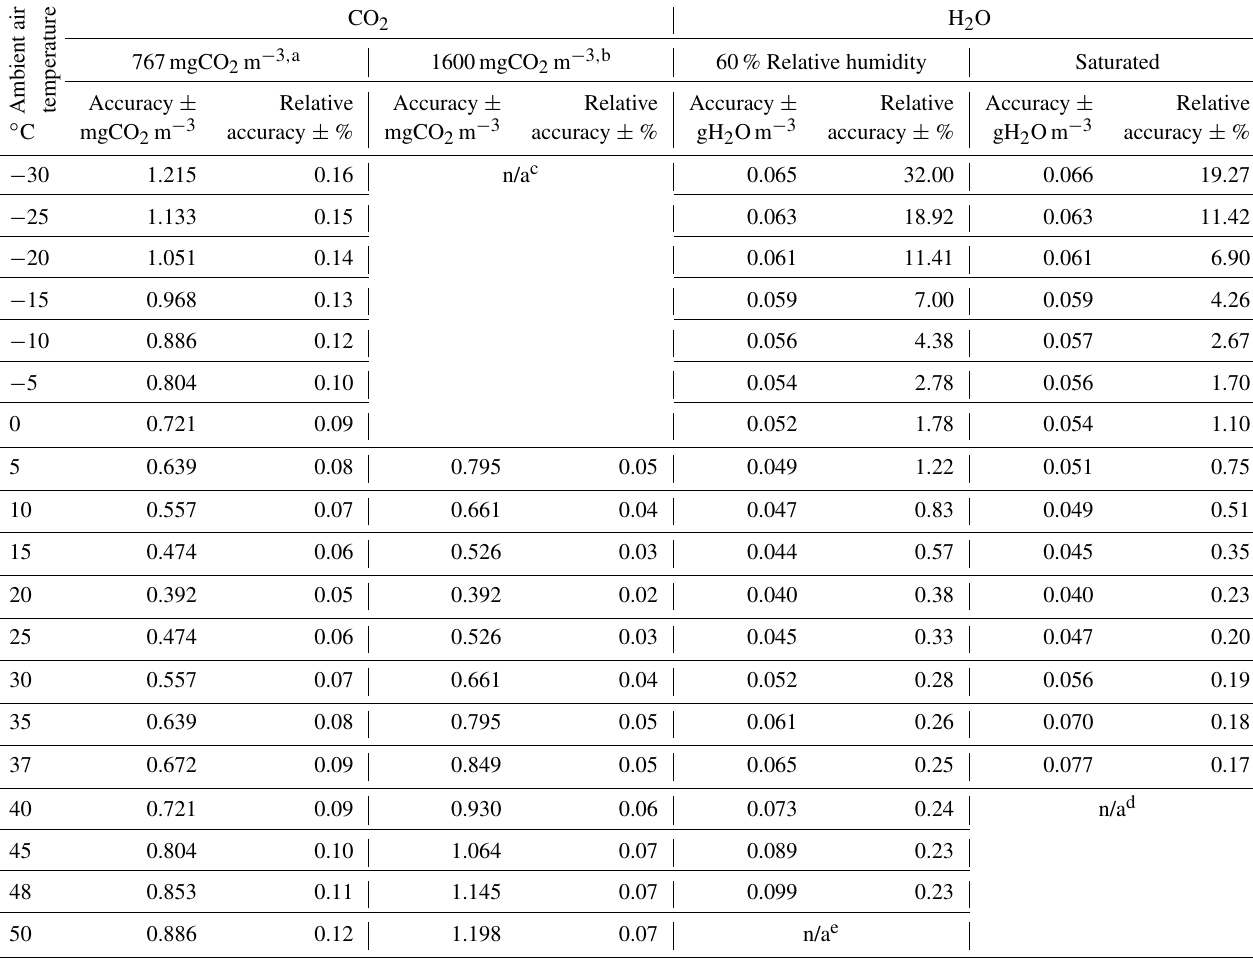
Table 2. Accuracies of field CO 2 and H 2 O measurements from open-path eddy-covariance systems by EC150 infrared CO 2 –H 2 O analyzers (Campbell Scientific Inc., UT, USA) on the major background values of ambient air temperature, CO 2 , and H 2 O in ecosystems. (Atmospheric pressure: 101.325kPa. Calibration ambient air temperature: 20 ◦